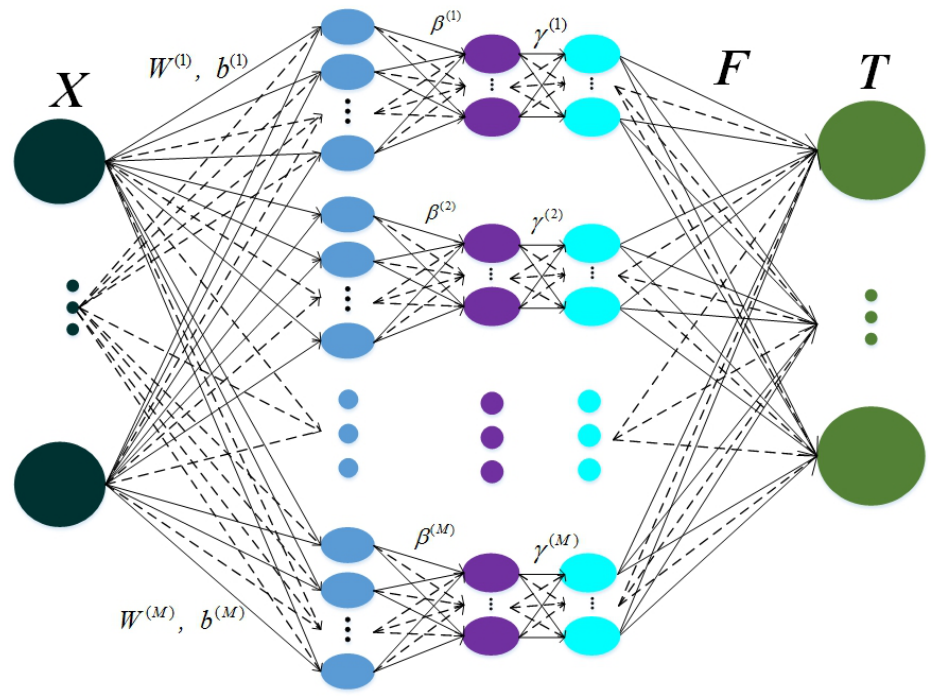
Figure 17. The proposed Extreme Learning Machine (ELM) can be seen as a three hidden layer neural network trained using the ELM